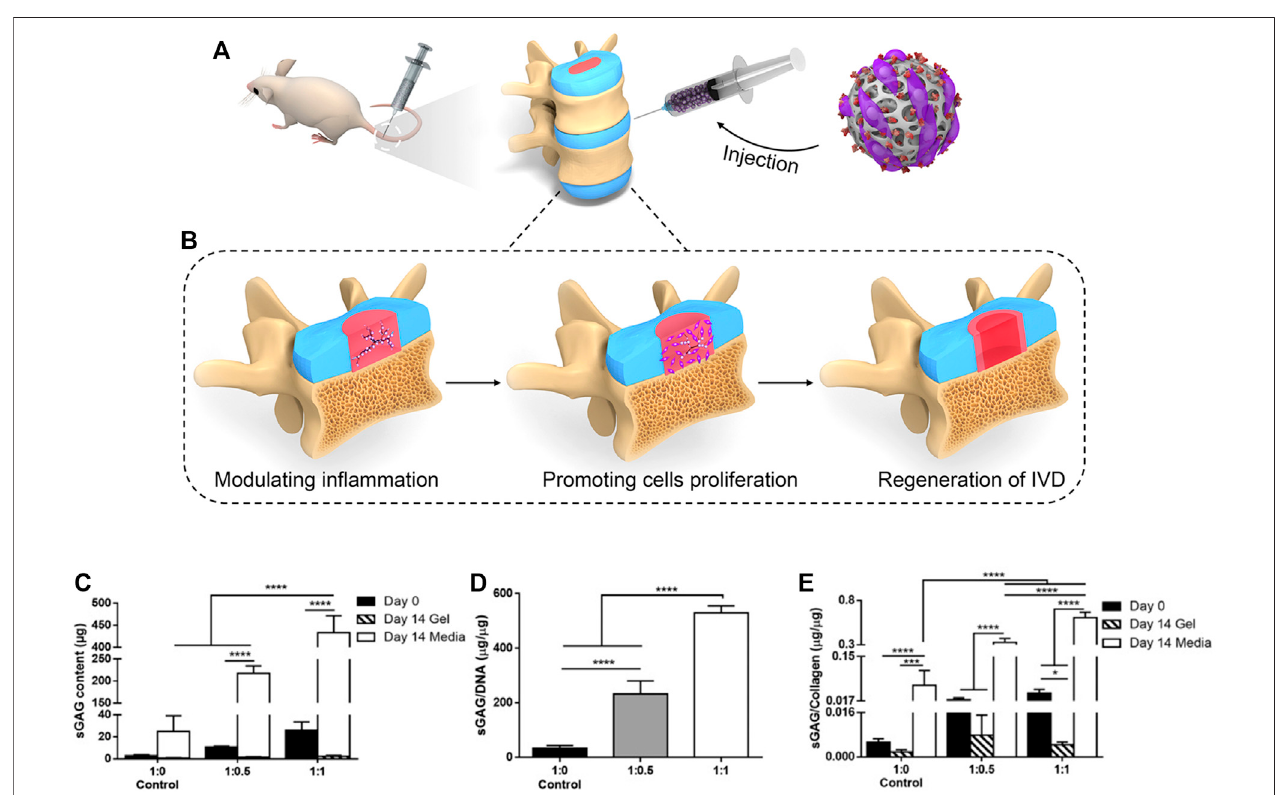
FIGURE2|(A) TheinjectionofHydrogelsintheratmodelofIVDdegeneration( (A) AdaptedfromBorrelliandBuckley(2020)) (B) Thefunctionprovidedbyhydrogel intheregenerationofIVDdegeneration,includingmodulatinglocalin fl ammation,romotingnucleuspulposuscellsproliferation,andregenerationoftheintervertebraldisk (IVD) (C,D) Synthesis of sGAG was found to be dependent on the initial gel composition, with signi fi cantly more sGAG being deposited by cells in gels containing higher initial sGAG. (E) The sGAG/collagen ratio was found to increase linearly with increasing CS present in the initial gel composition. ( (B – E) Adapted from Bian et al.